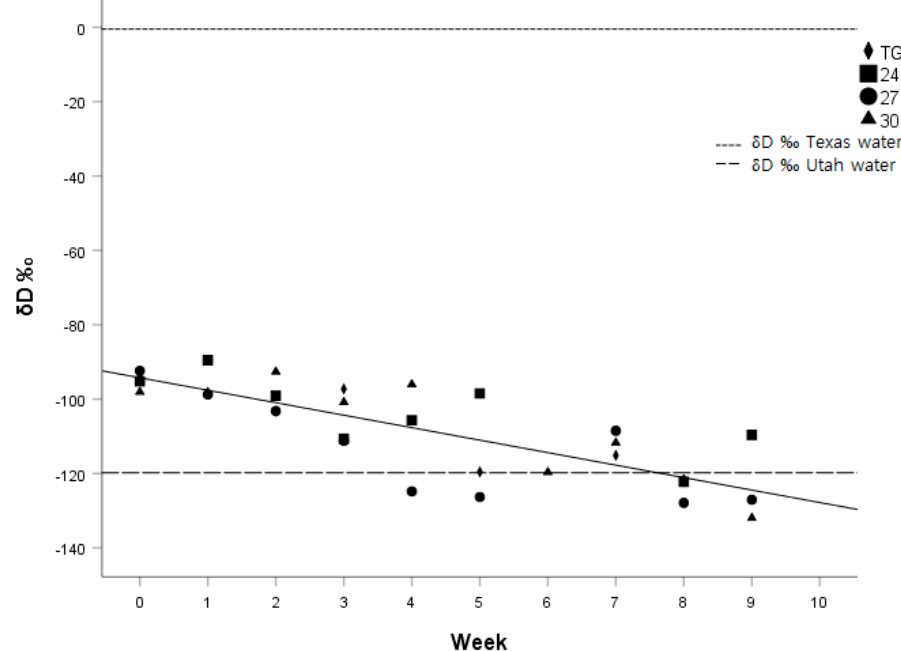
Figure 3. The δ D ‰ values of scales of corn snakes ( Elaphe guttata ) for the three treatment groups and the thermoregulating group. Squares represent snakes held at a constant 24 ◦ C, circles represent snakes held at a constant 27 ◦ C, triangles represent snakes held at a constant 30 ◦ C, and diamonds represent snakes allowed to freely thermoregulate. The short-dashed line represents the δ D value of the water they were given previous to the experiment in Texas ( − 0.5 ‰ ) and the long-dashed line represents the δ D value of the water they were given during the experiment in Utah ( − 119.8 ‰